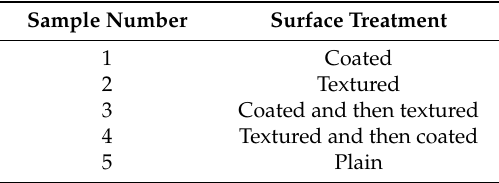
Table 2. Sample’s specifications.